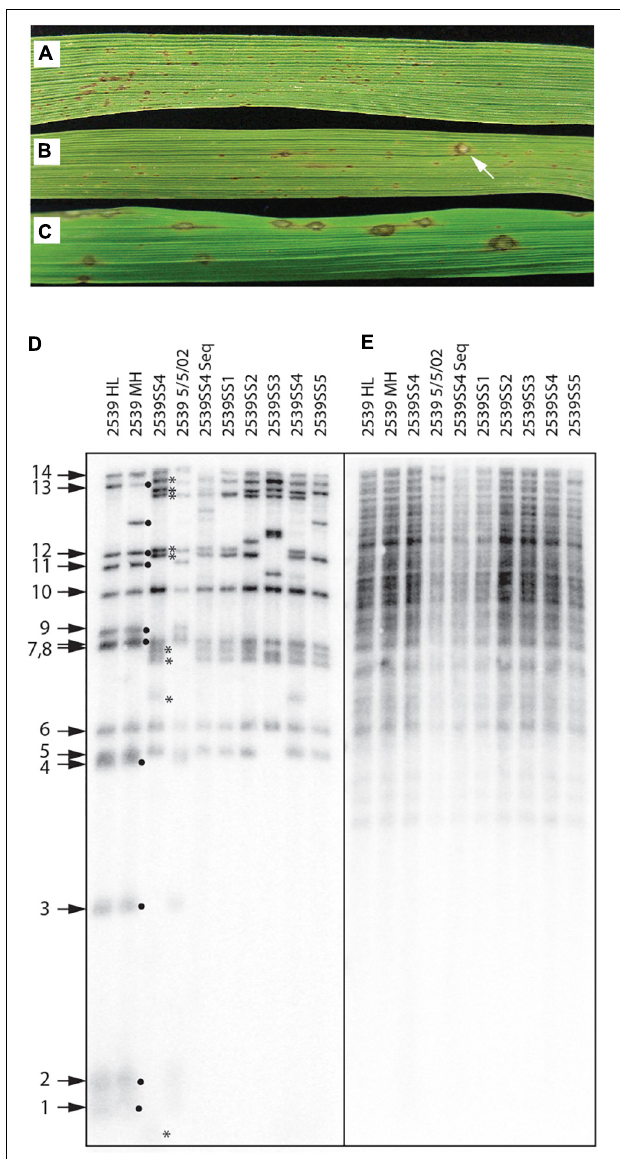
FIGURE 9 | Telomere failure associated with an adaptive event. (A) Typical infection phenotype of avirulent strain, 2539, on rice cultivar 51583; (B) Gain of virulence for 2539 on 51583 as indicated by the presence of a rare single lesion; (C) Infection phenotype of a single-spore (SS) culture recovered from the lesion shown in panel (B) shows that the gain of virulence is stable; (D) Telomere fingerprints of single-spore cultures recovered from the lesions compared with several lab stocks of 2539 reveal alterations of telomeric fragments in the SS cultures recovered from the rare lesion; (E) DNA fingerprinting of the same strains shown in panel (D) using a hybridization probe that targets two dispersed repetitive elements (MGL and